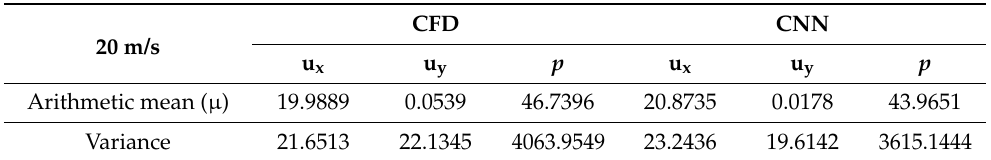
Table 4. Comparison of arithmetic mean and variance between the ground-truth CFD data and the CNN predictions for the streamwise velocity of 20 m/s.